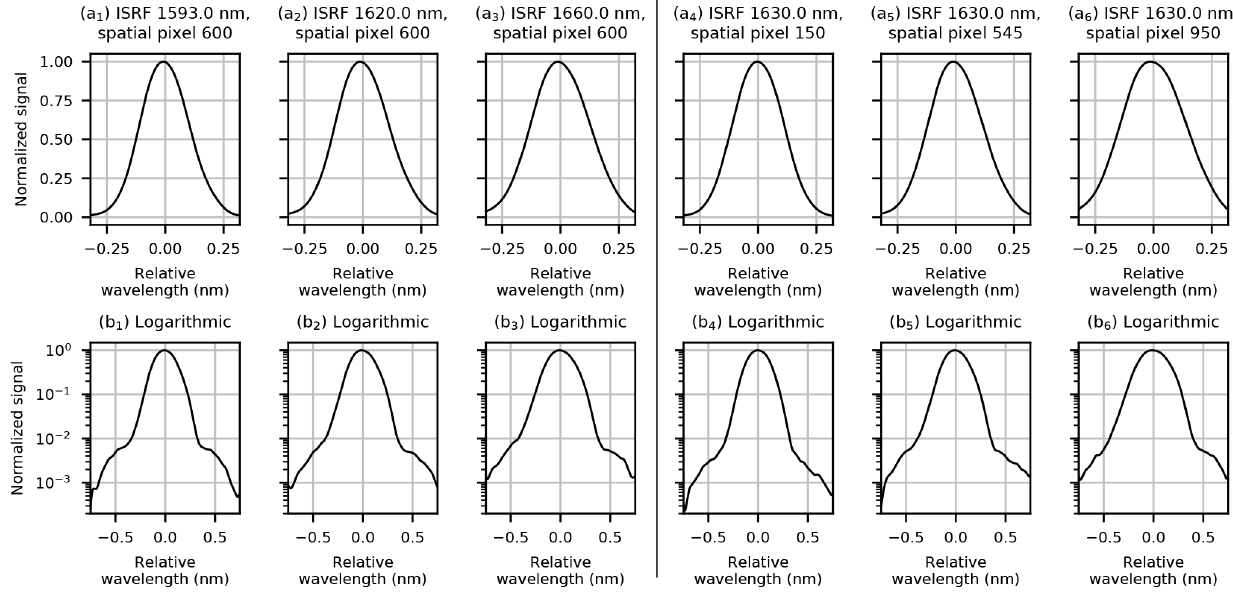
Figure 12. ISRF shapes at various positions for the CH 4 band. The first three panels (a1–a3) demonstrate the variation in shape for different central wavelengths at a constant spatial position, while the rightmost three panels (a4–a6) hold central wavelength constant to show ISRF changes across spatial pixels. The bottom row of panels (b1–b6) displays the same data on a logarithmic scale and wider relative wavelength range. The ISRFs are normalized so the maximum is unity.